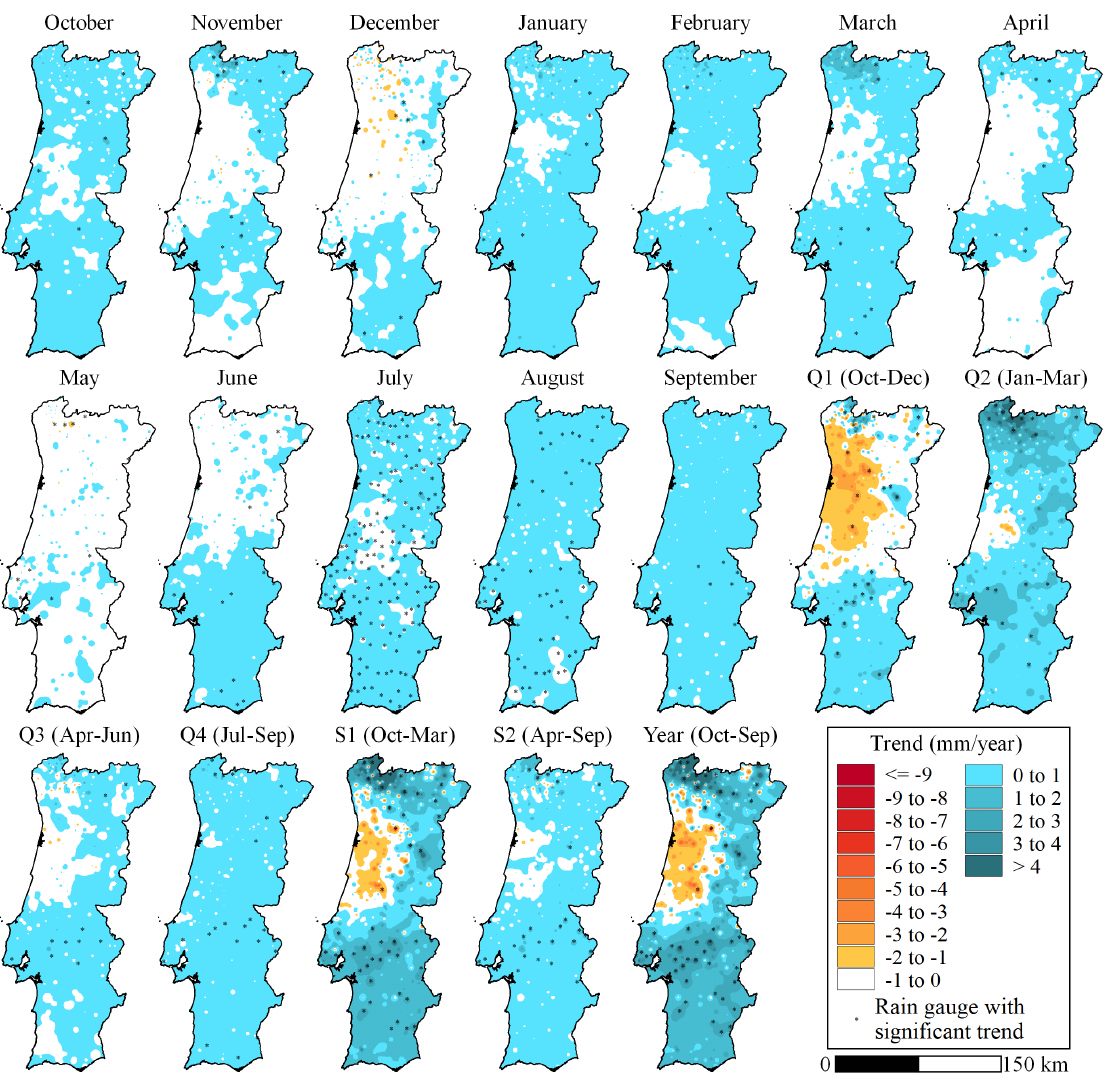
Figure 7. Spatial distribution of the Sen’s slope for the monthly, quarterly (Q1 to Q4), semi-annual (S1 and S2) and annual rainfall in the initial sub-period, from 1913/1914 to 1967/1968 (55 years). Only the rain gauges with significant trends are schematically located in the